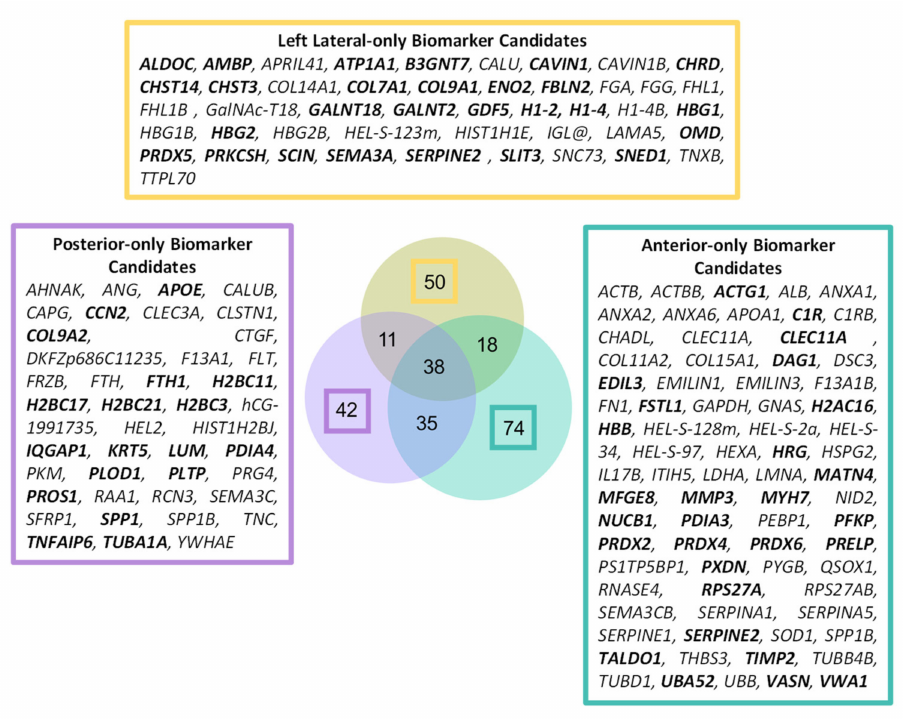
Figure 4. A total of 166 proteins were identified with significant, age-associated structural differences that were entirely IVD-region specific. The affected proteins which were uniquely discovered by PLF and not by label-free quantification of abundance in the DIPPER study (Figure S3) [13] are highlighted in